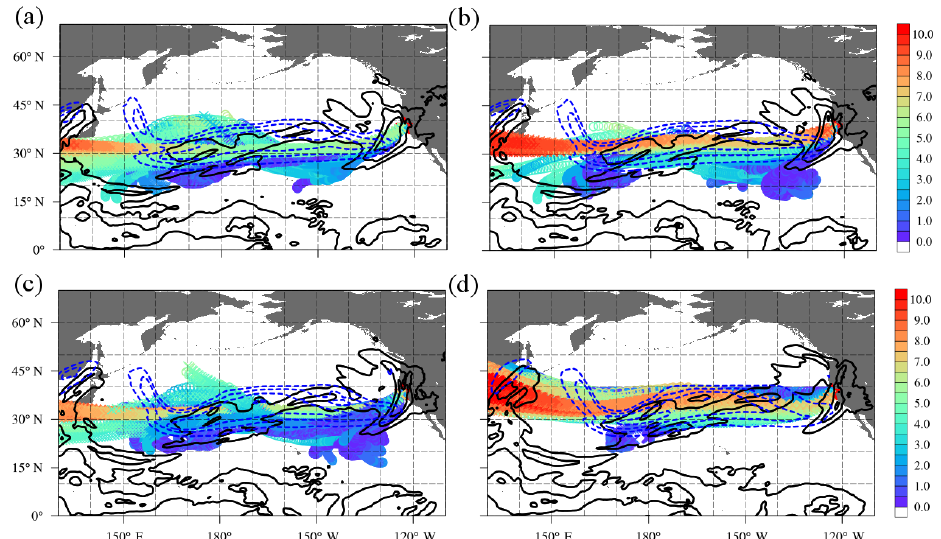
Figure 6. (a) FLEXPART backward-simulated element position for releases from cloud top (“X” markers) and mixed-phase (“O” markers) layers over CZC during the Early AR period. Marker color denotes element altitude (kma . m . s . l . ). Period average IVT from CFS is shown by black contours from 250 to 750kgm − 1 s − 1 every 250kgm − 1 s − 1 . Period average horizontal wind speed in the jet layer (see Sect. 3a for layer definition) is shown by blue dashed contours from 50 to 70ms − 1 every 10ms − 1 . (b) As in (a) , except for the Barrier Jet period. (c) As in (a) , except for the Peak AR period. (d) As in (a) , except for the Post-CF period. Table 4. Probability of instantaneous element residence in features of interest P res , during FLEXPART backward simulation given a element arrived in the labeled period and layer. Nonzero P res values are bold. Feature Period and layer (mixed phase: MP; cloud top: CT) Early AR Barrier Jet Peak AR Post-CF MP CT MP